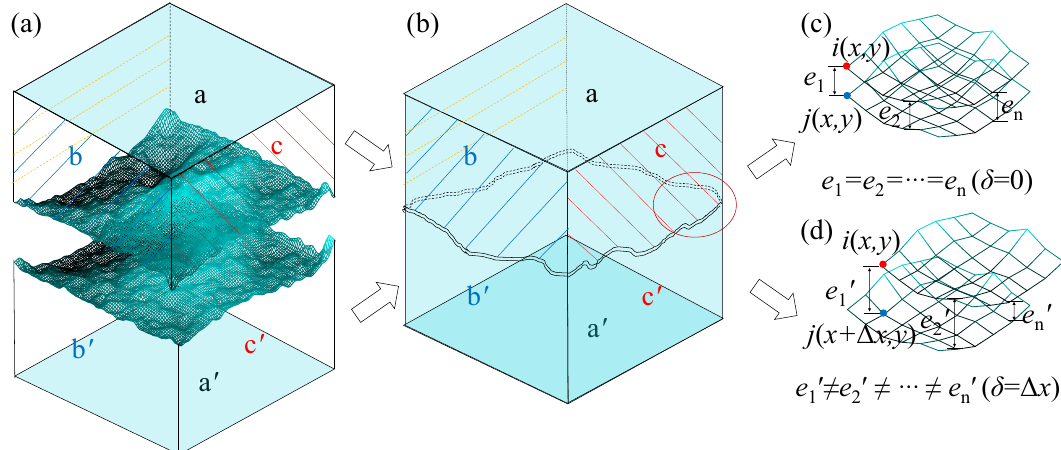
Figure 6. Calculation process for GLSTD. ( a ) upper and lower halves of the joint sample obtained by 3D scanning, ( b ) matching the upper and lower halves together for 3D scanning, ( c ) initial GLSTD, and ( d ) GLSTD at shear displacement ( δ ) is Δ x